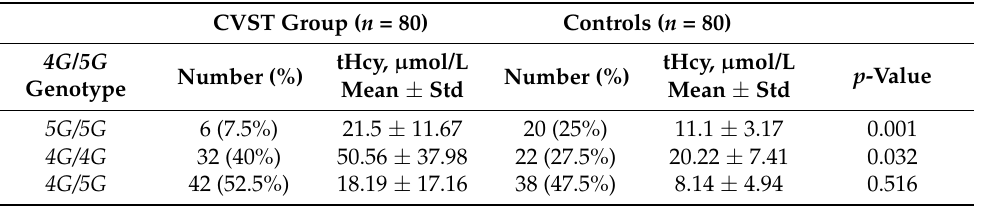
Table 2. Comparison of homocysteine (tHcy) levels according to PAI-1 gene polymorphism in the CVST group and controls